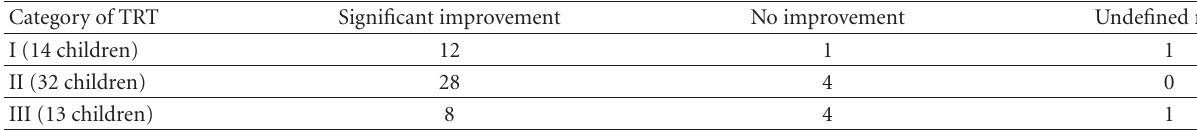
Table 4: The result of TRT in the subsequent categories.